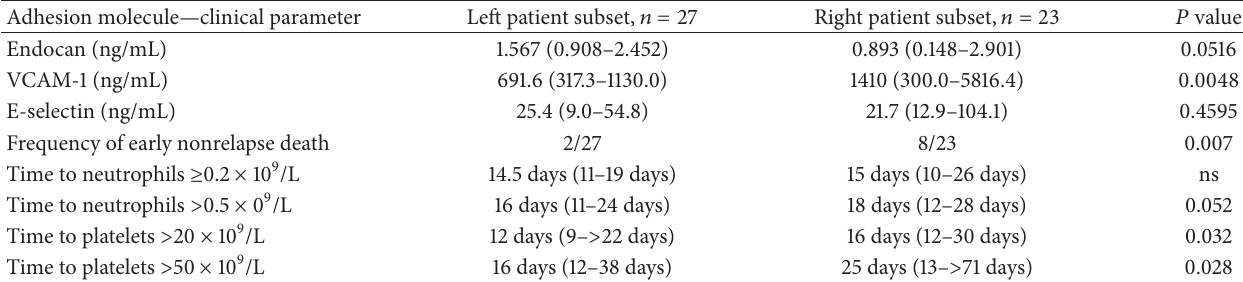
Table 2: Unsupervised hierarchical clustering of serum soluble adhesion levels for 50 unselected patients treated with allogeneic stem cell transplantation; a comparison of the two main patient subsets including the 23 patients to the right and the 27 patients to the left in Figure 2,